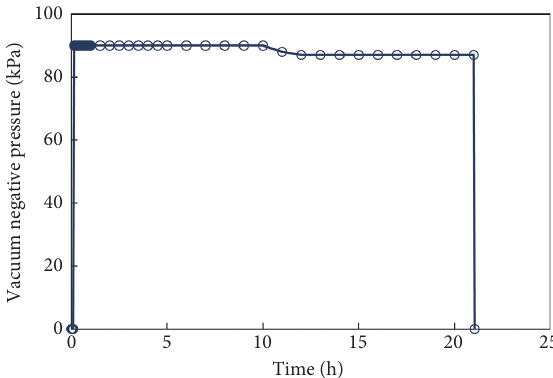
Figure 6: The vacuum negative pressure load of sludge dewatering with rice